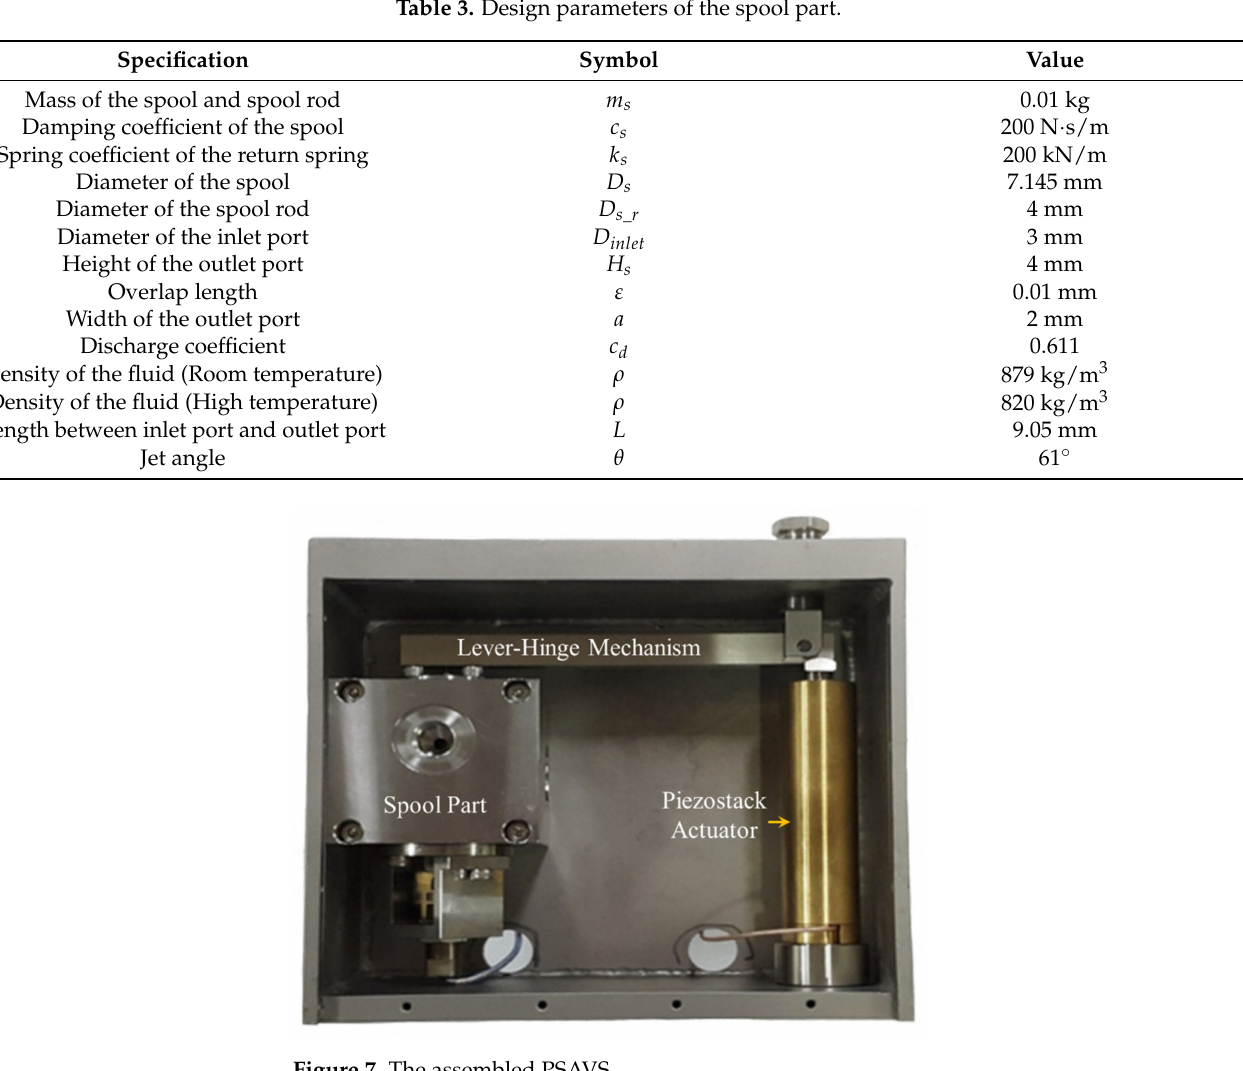
Figure 7. The assembled